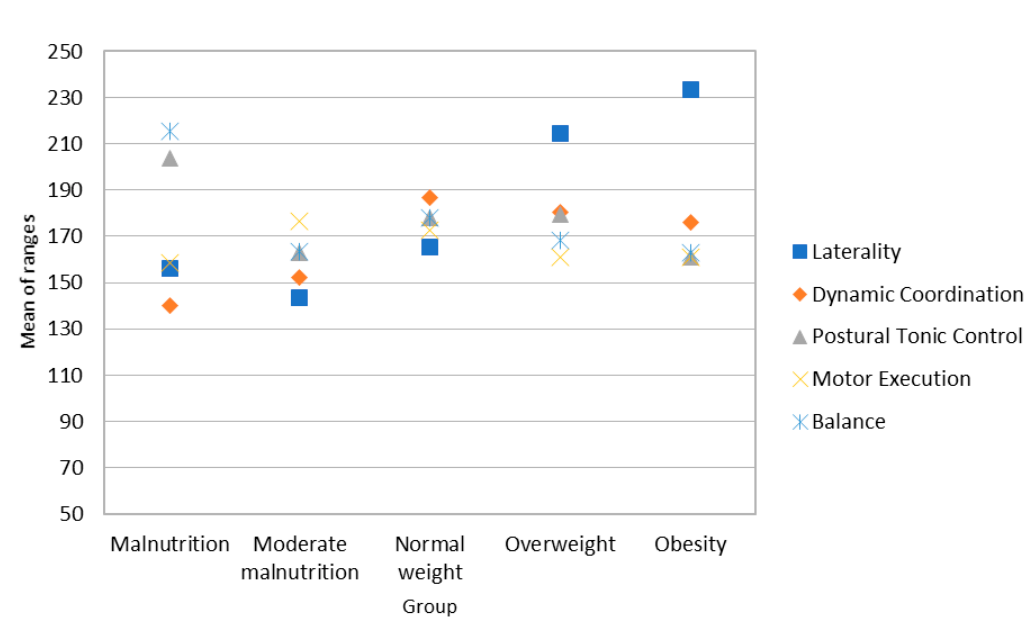
Table 5. Kruskal-Wallis test and descriptive statistics for perceptual skills according to BMI for the sample of girls.